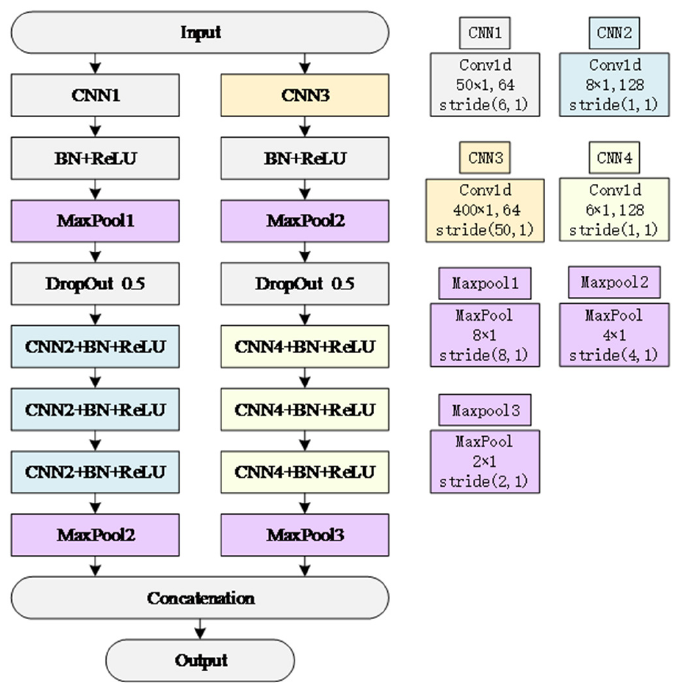
Figure 3. Time-domain and frequency-domain feature extraction by using a CNN.